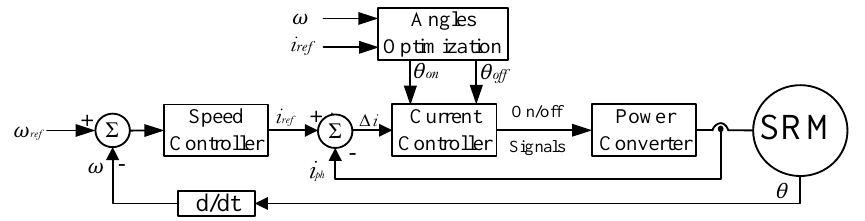
Figure 8. Block diagram of SATC.